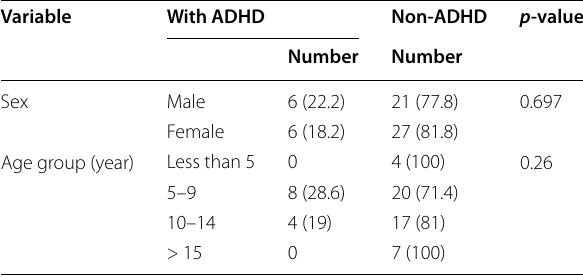
Table 3 Frequency distribution of attention-deficit hyperactivity disorder by age and